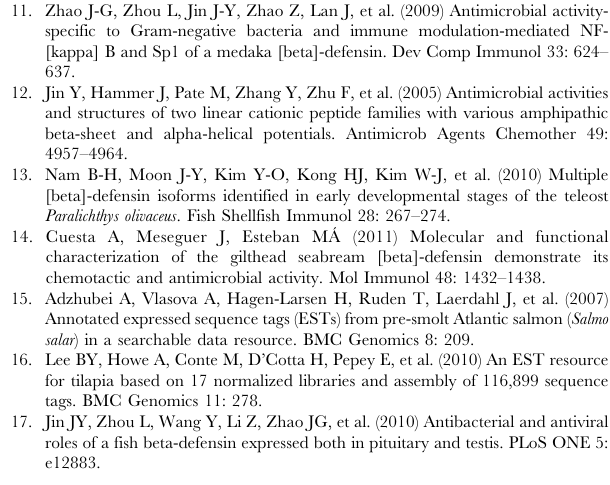
Table S1 Matches for unspecific trypsin cleavage of cod defensin. Positions of peptide fragments and their monoisotopic masses are indicated. The identified fragments covered the entire cod defensin sequence (FPWSCPTLSG VCRKVCLPTE MFFGPLGCGK EFQCCVSHFF). (DOCX)